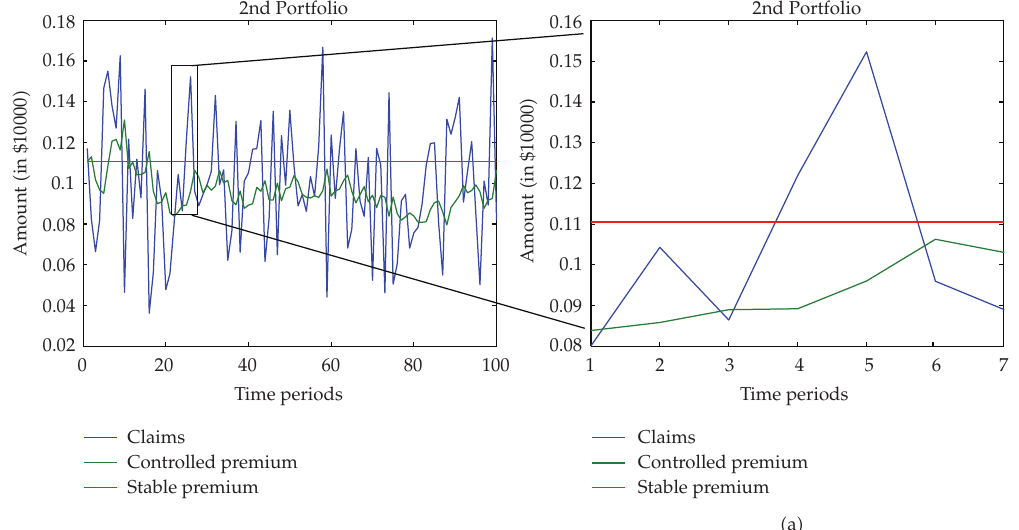
Figure 2: 2nd class of a heterogeneous Portfolio, during 100 unit-time period (cid:5) an enlargement region, where the results are more clear (cid:7)